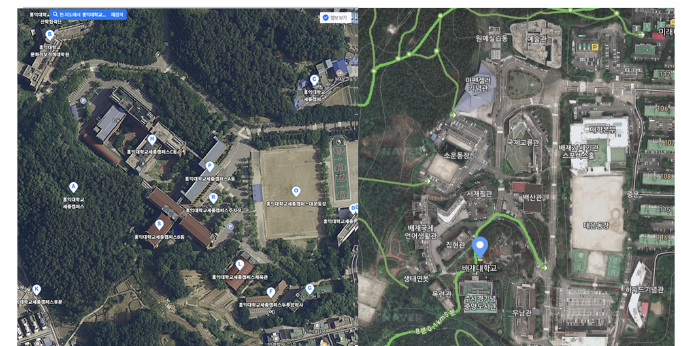
Figure 5. Satellite map of the experimental space.